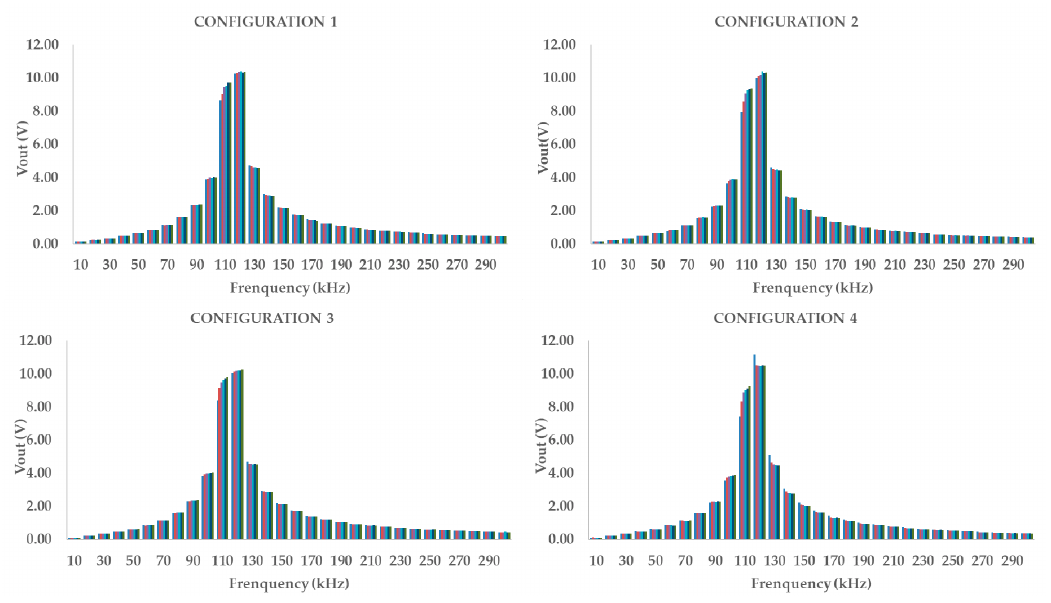
Figure 8. Representation of the frequency spectrum of P2 in the four different studied cases.